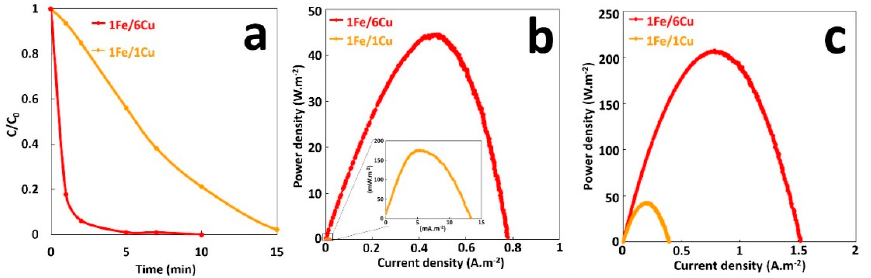
Figure 6. ( a ) Effect of Cu/Fe area ratio on the degradation of MG dye during the GF process, ( b ) Power curves of the GF process obtained with different Cu/Fe area ratios during degradation process (GF-B configuration), ( c ) Power curves of Fe/Cu couple without the Fenton reaction for different area ratios (GF-A configuration).